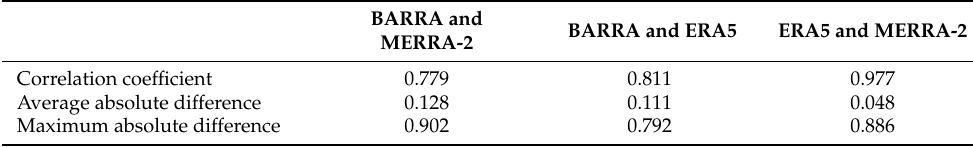
Figure 3. Maps of average capacity factors (2009–2018) predicted by each dataset. Table 3. Variation in capacity factors predicted by each